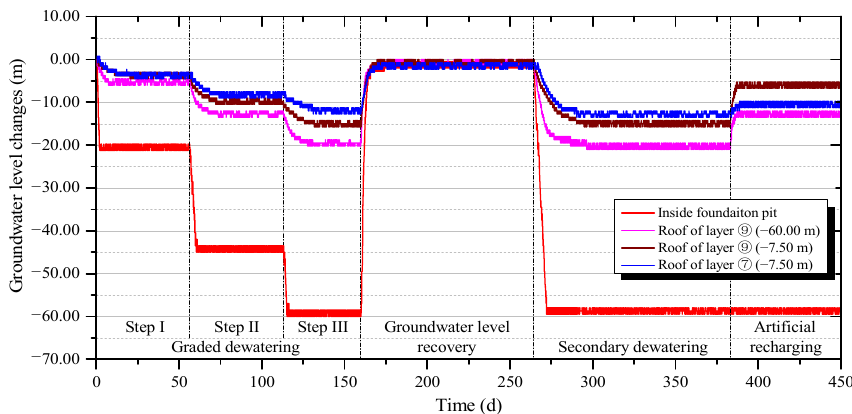
Figure 7. Earth pressure around the tunnel at JS–3.